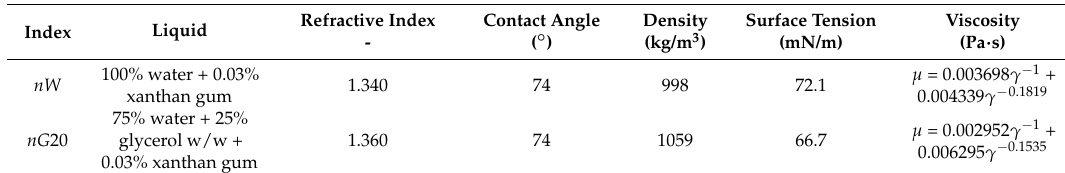
Table 1. Physical properties of liquids used.